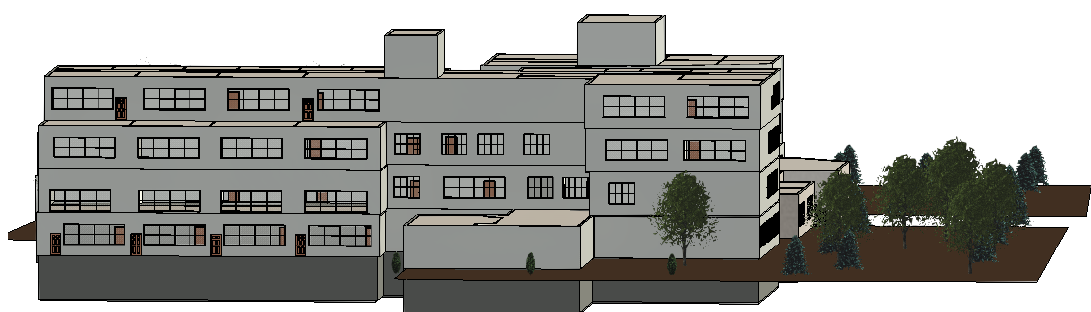
Figure 6. East view of the building. 3. Results After the building spaces are created, and the thermal characteristics of the shell elements are defined, the desired conditions of temperature and humidity, lighting levels, and operating hours are selected. The space data are used to calculate the capacity of the building, as well as to perform energy analyses. In the table below (Table 7), the cooling and heating loads of the university building, as calculated by Revit, are presented. Table 7. Cooling and heating loads and airflow summary table. Building in Mallorca